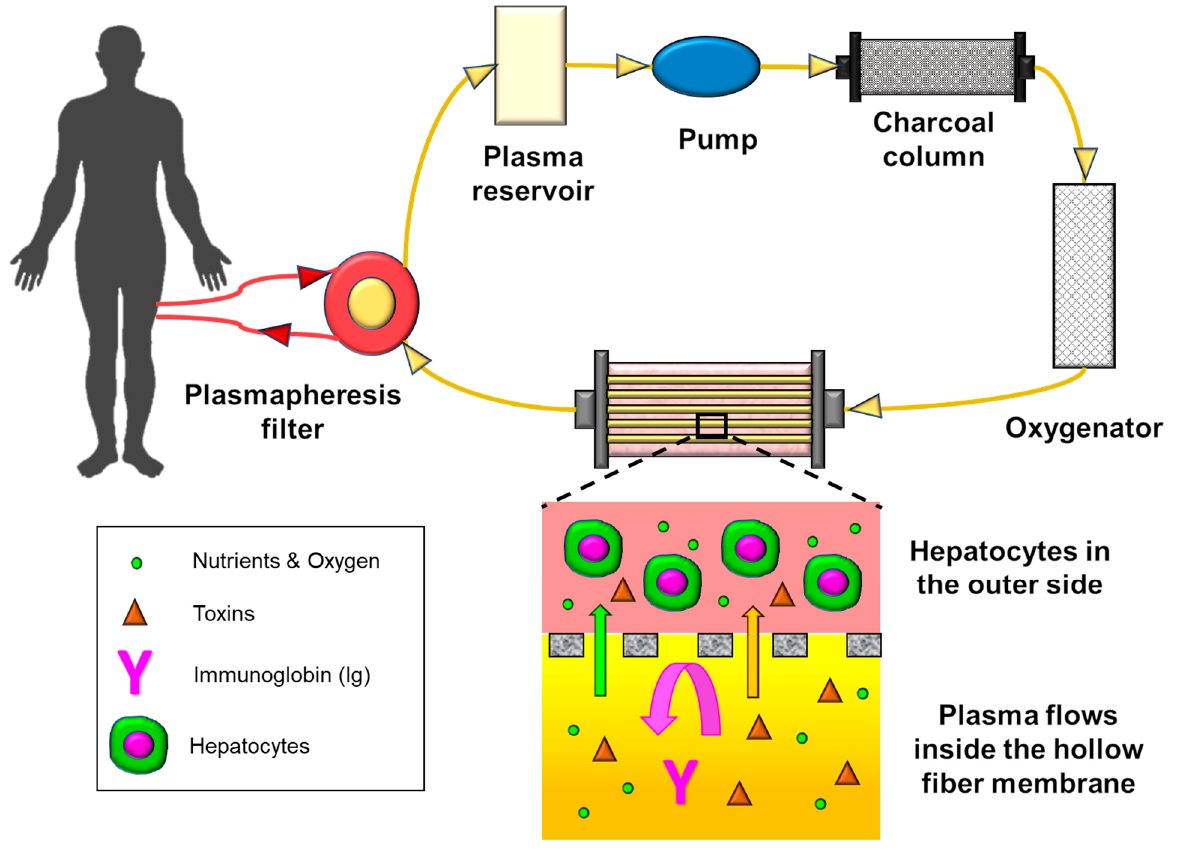
Figure 15. Bioartificial liver schematic. 240